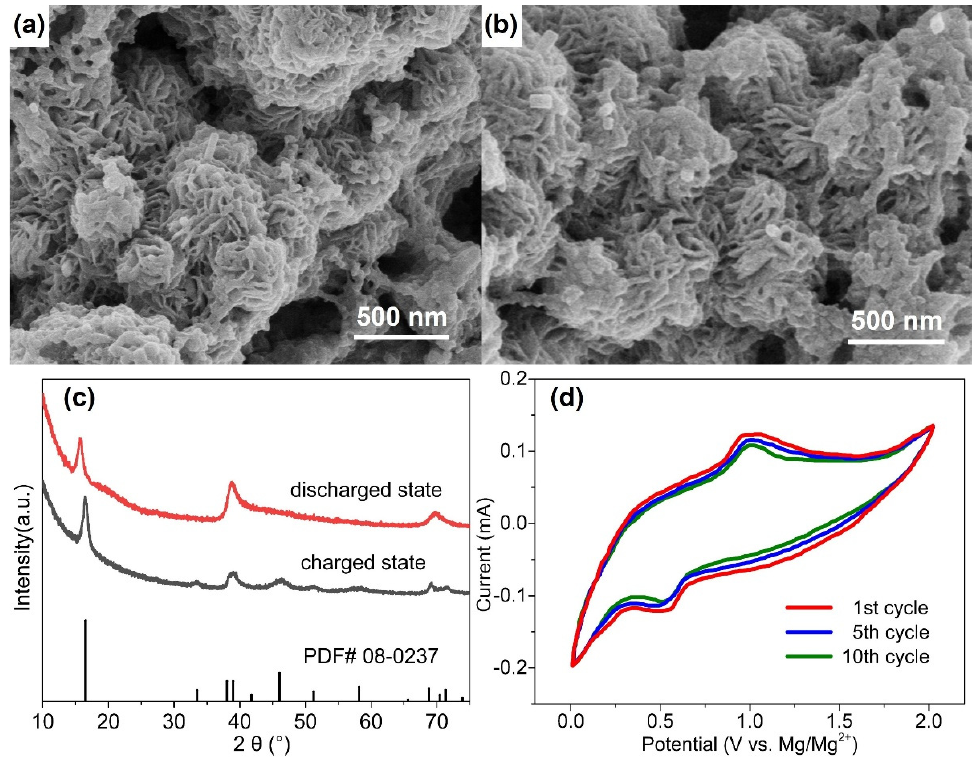
Figure 4. SEM micrographs of WS 2 electrode (WS 2 -OX-PVP) in DMM electrolyte before the 1st cycle at charged state ( a ) and after the 100 cycle at discharged state ( b ); the corresponding XRD patterns are shown in ( c ); cyclic voltammetry of WS 2 -OX-PVP at a scan rate of 1 mV/s in DMM electrolyte in the potential window of 0–2 V is shown in ( d ).